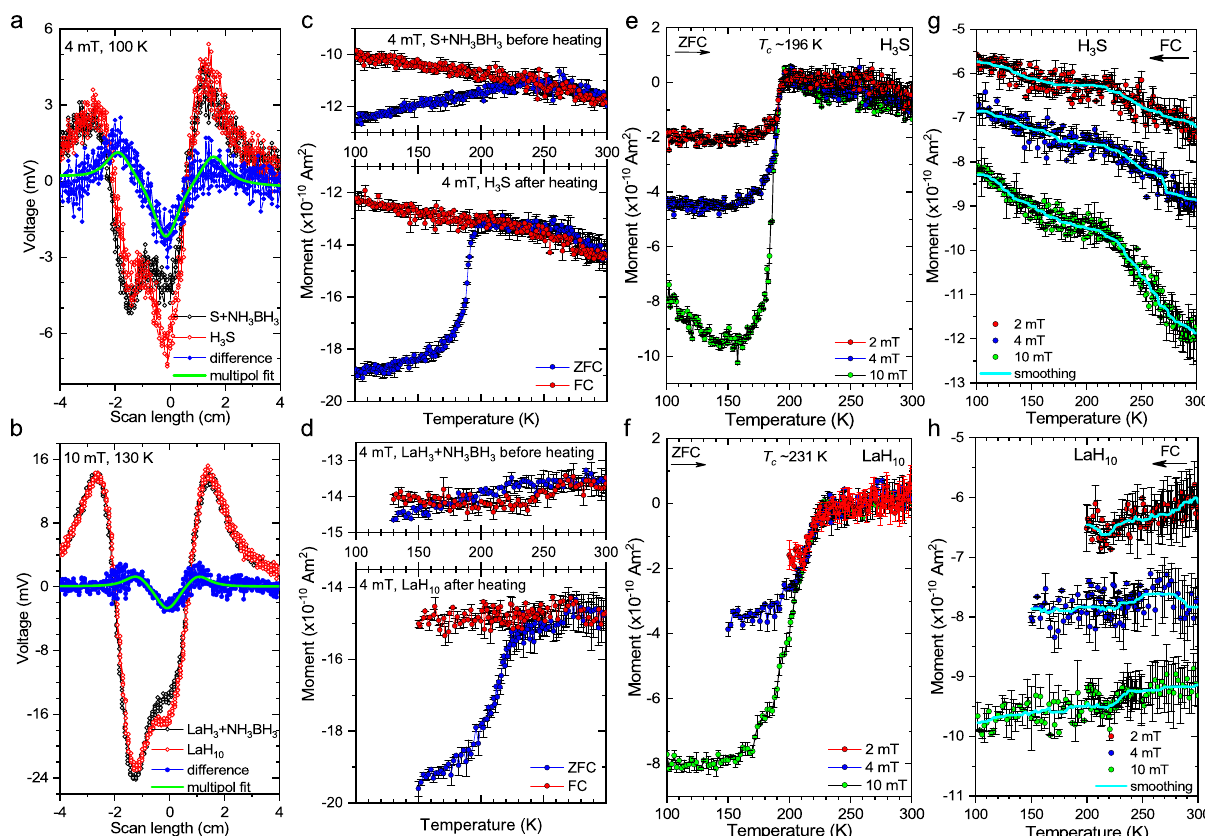
Fig. 2 Expulsion of magnetic fi eld by the superconducting Im-3m -H 3 S and Fm-3m -LaH 10 phases at P S = 155 ± 5 GPa and P S = 130 ± 8 GPa, respectively. a , b Appearance of the diamagnetic signal in the raw SQUID output signal of ZFC samples containing the superconducting Im-3m -H 3 S and Fm-3m -LaH 10 phases under low magnetic fi elds below their T c s. Black circles correspond to data measured for the compressed S + NH 3 BH 3 and LaH 3 + NH 3 BH 3 sandwiched samples at P D ∼ 167 GPa before laser heating, red circles correspond to data collected from heated samples with Im-3m -H 3 S and Fm-3m -LaH 10 phases. The blue circles show the difference, whereas the green curve shows the fi t. The position at 0 cm corresponds to the center of the pickup coil relative to which the superconducting samples were centered (see “ Methods ” ). c , d ZFC and FC portions of M ( T ) measurements of the sandwiched samples with metallic S and LaH 3 (top panel) and heated samples with Im-3m -H 3 S and Fm-3m -LaH 10 phases (bottom panel), respectively. e , f ZFC portions of M ( T ) magnetization data for the Im-3m -H 3 S and Fm-3m -LaH 10 phases at 2, 4 and 10 mT after subtraction of the background signal measured from the DACs with the pressurized unheated sandwiched samples. g , h FC portions of M ( T ) data measured at 2, 4 and 10 mT after formation of the Im-3m -H 3 S and Fm-3m -LaH M ( T ) data of the initial pressurized and heated samples are 10 phases. The curves were vertically translated for better representation. The raw summarized in Supplementary Figs. S2 and S3. Smoothed by a percentile fi lter, light blue curves demonstrate the subtle Meissner effect in FC Fig. S4. At low temperatures, the s -wave model of conventional superconductivity well reproduces the data for both compounds.